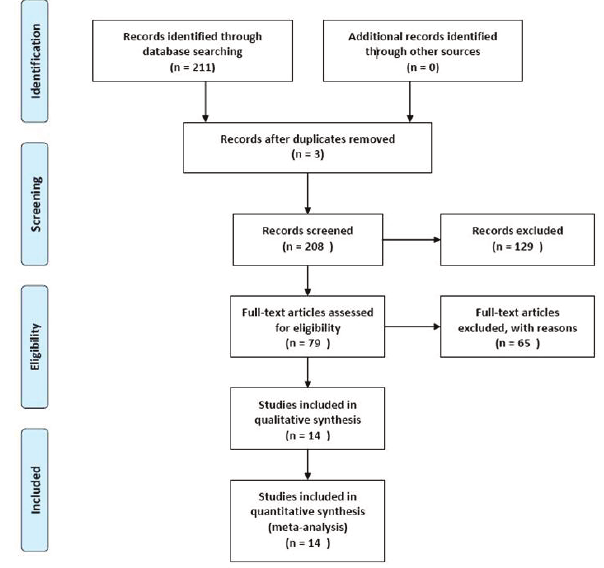
Figure 1: The publication searching flow